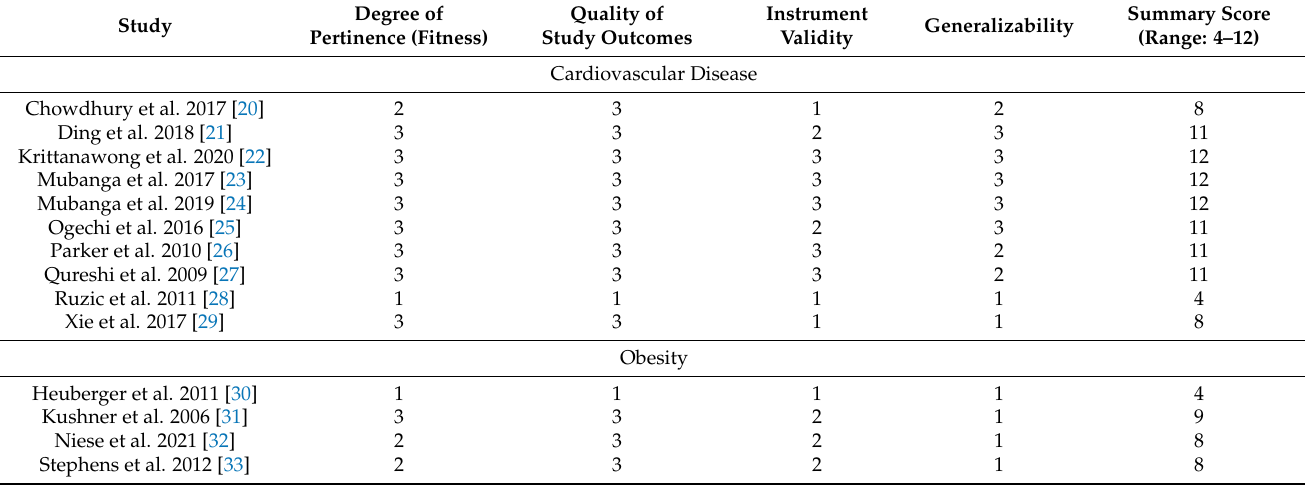
Table 2. Quality/bias assessment of studies ( n = 14) that met inclusion